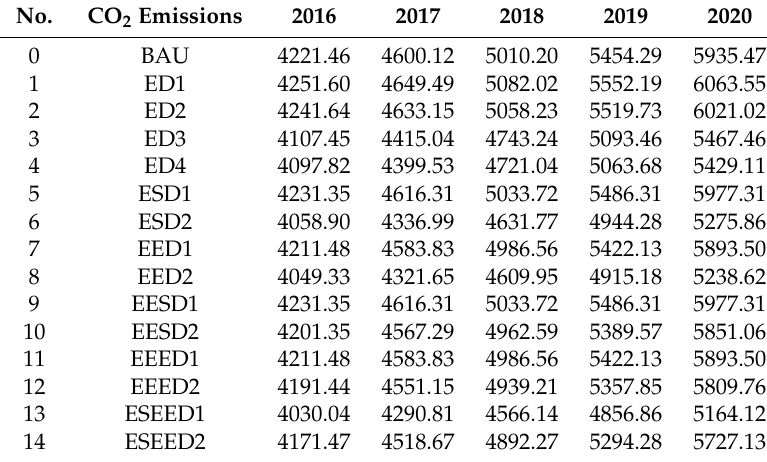
Table 7. CO 2 emissions from the power industry under different scenarios (unit: